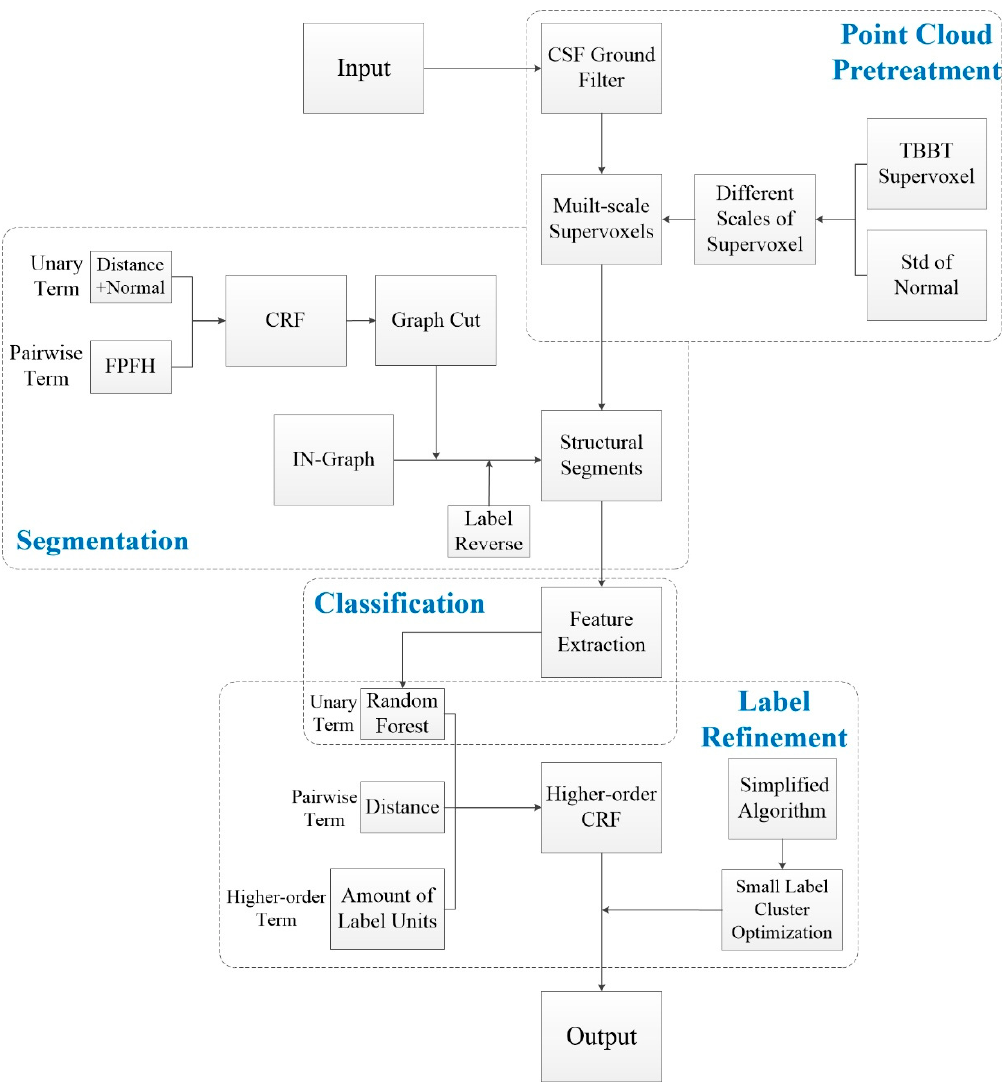
Figure 1. Overall flow of the proposed semantic segmentation method.